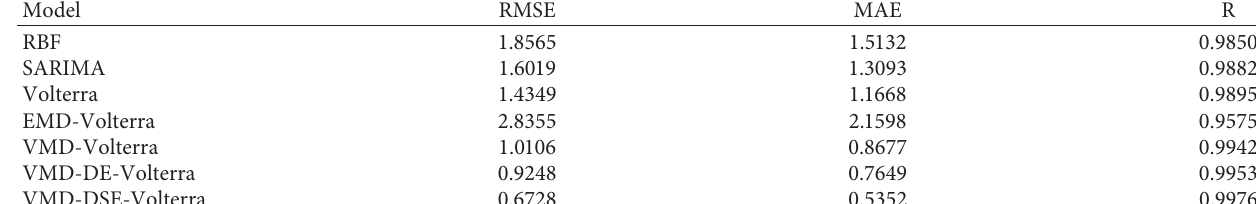
Table 5: Error analysis of each prediction model in Yan’an area.